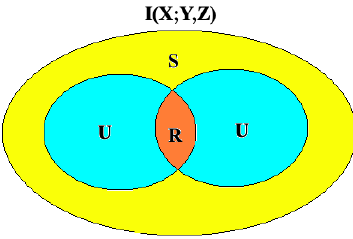
Figure 1. Information exchange from two sources, Y and Z , to the target X decomposed according to PID as unique information (U), redundant information (R), and synergistic information